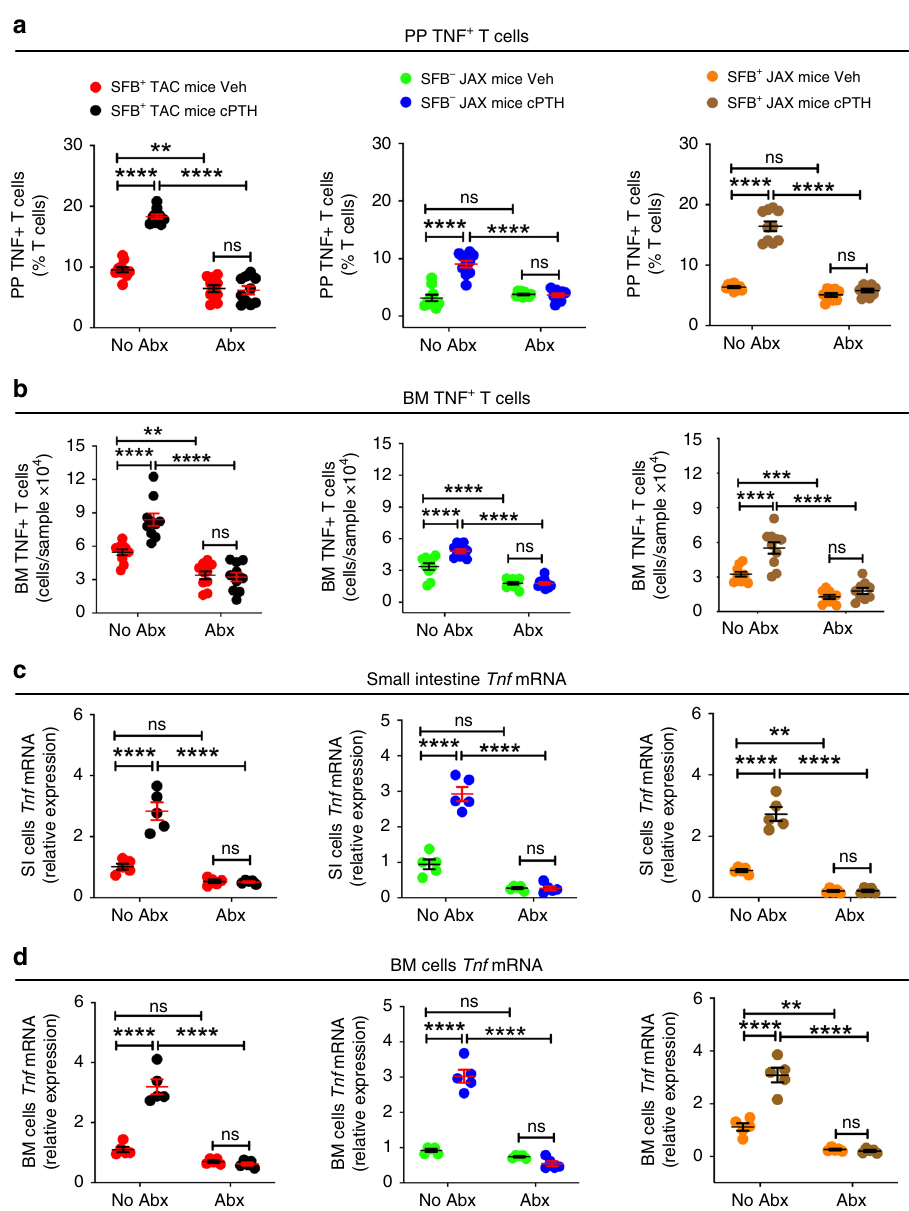
Fig. 6 SFB − microbiota is suf fi cient for cPTH to expand intestinal and BM TNF + T cells. a Relative frequency of PP TNF + T cells, n = 9 – 10 mice per group. b Absolute number of BM TNF + T cells, n = 9 – 10 mice per group. c , d SI and BM levels of Tnf transcripts. SFB + TAC and JAX mice and SFB - JAX mice were treated with cPTH with antibiotics (Abx) or without antibiotics (No Abx) for 2 weeks, n = 5 mice per group. All data were normally distributed according to the Shapiro-Wilk normality test. Data were analyzed by two-way ANOVA and post hoc tests applying the Bonferroni correction for multiple comparisons. ** p < 0.01, *** p < 0.001, and **** p < 0.0001 compared to the indicated group. Source data are provided as a Source Data fi le.